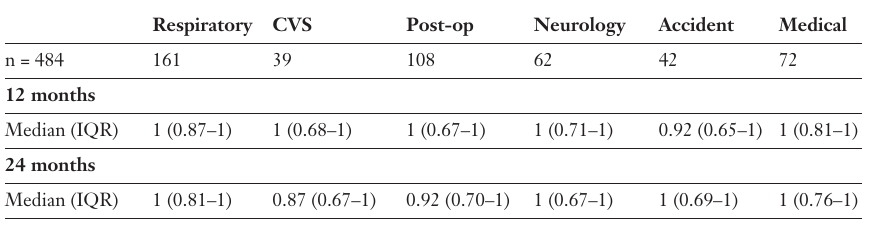
Table 4 Mortality rate in the different PIM groups during PICU admis- sion and during the 24 months’ follow-up